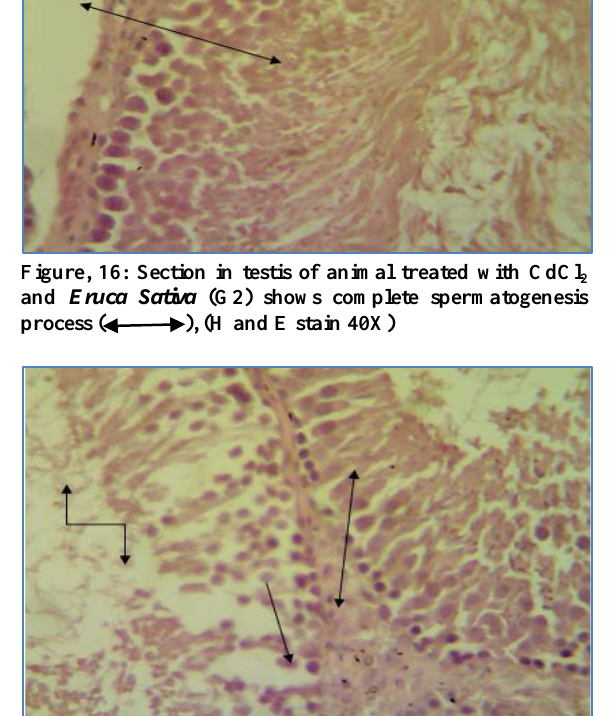
Figure, 17: Section in testis of animal treated with CdCl 2 and Eruca Sativa (G2) shows thickness of interstitial tissue ( ) with complete Spermatogenesis process in most seminiferous tubules ( ) but few of the expressed incomplete spermatogenesis process ( ), (H and E stain 40X).